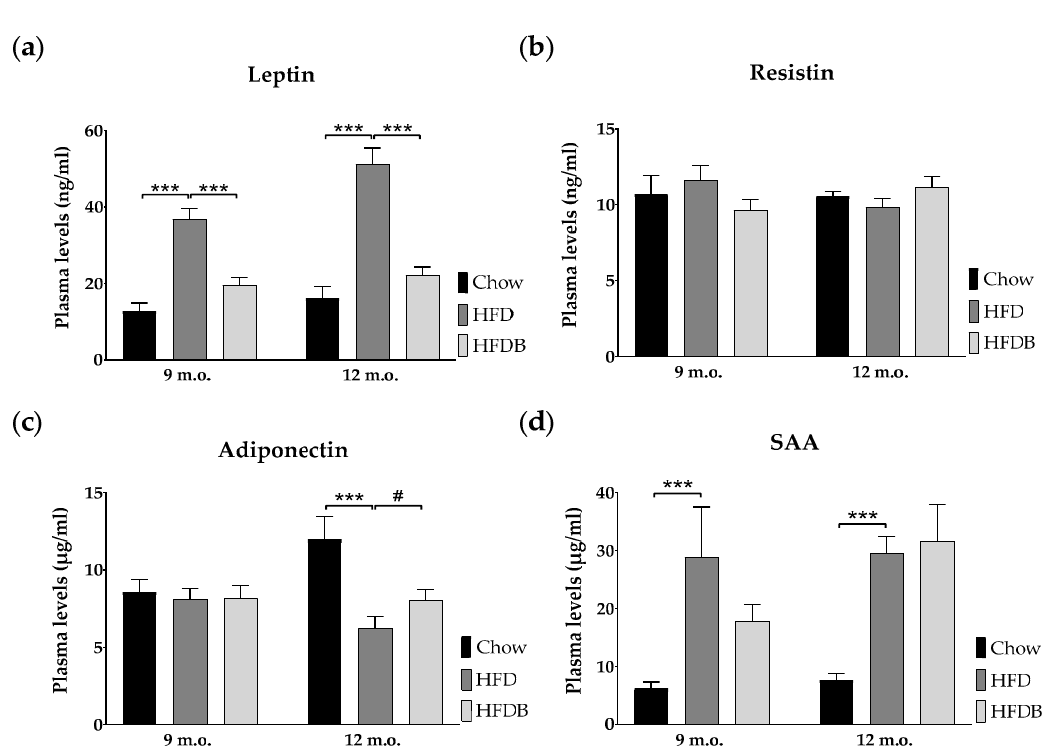
Figure 3. Adipokine plasma levels. Mean plasma levels of leptin ( a ), resistin ( b ), adiponectin ( c ), and serum amyloid A (SAA) ( d ) are represented in both mid- (9 m.o.) and late- (12 m.o.) adult mice as mean ± SEM. *** p ≤ 0.001; # p = 0.053.